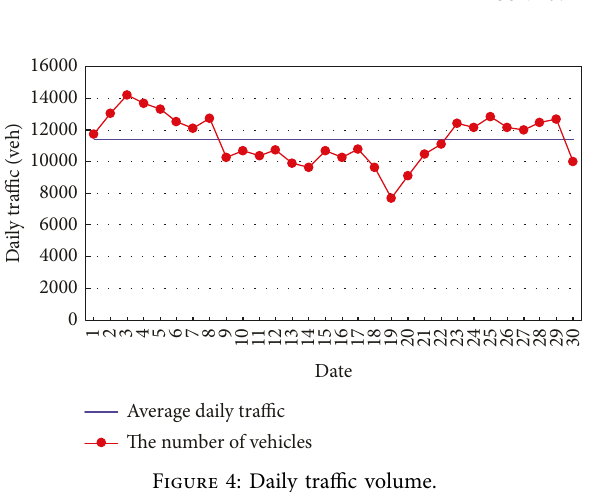
Figure 3: Bridge lane number.